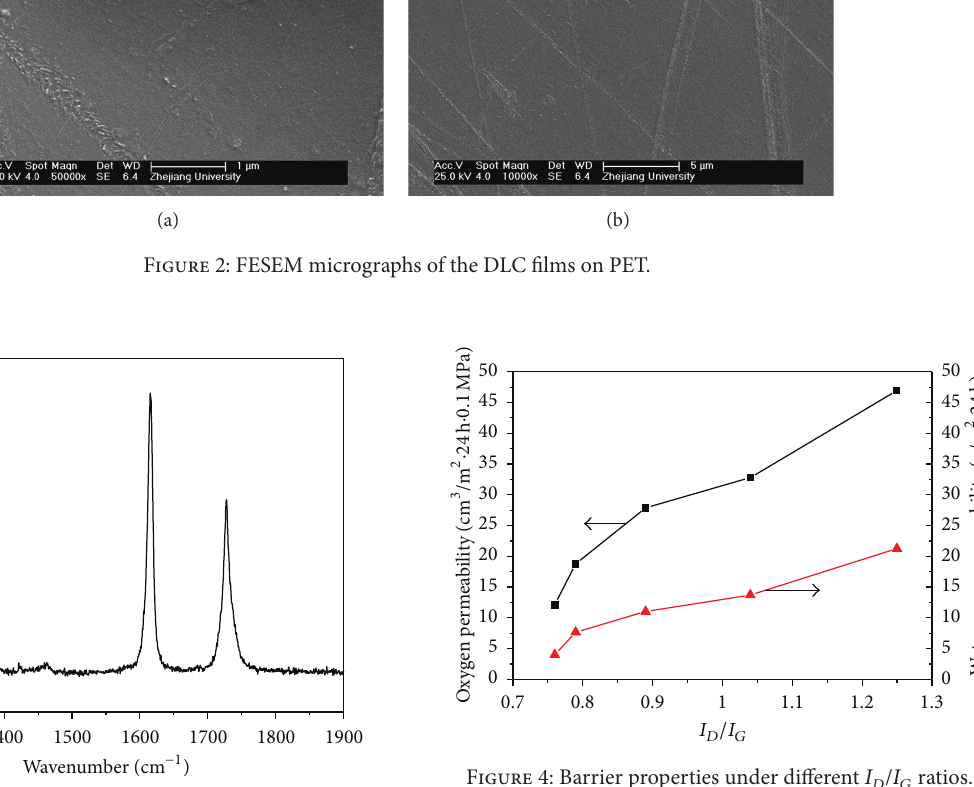
Figure 3: Raman spectrum of DLC films on PET.